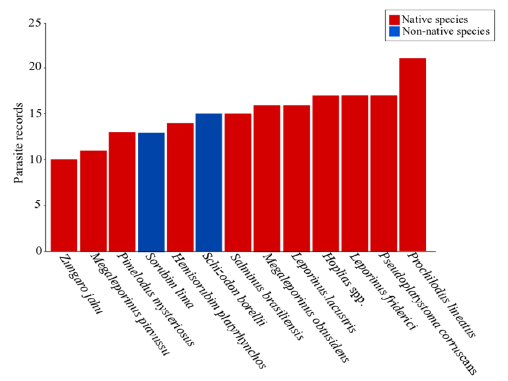
Figure 8. Richness of parasites for the hosts with the most